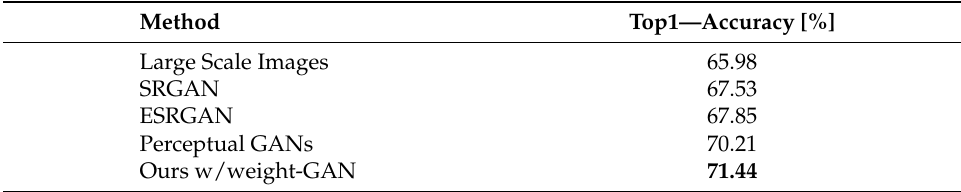
Table 2. Comparisons of detection performance with different methods on weight-GAN sub-network datasets generated from